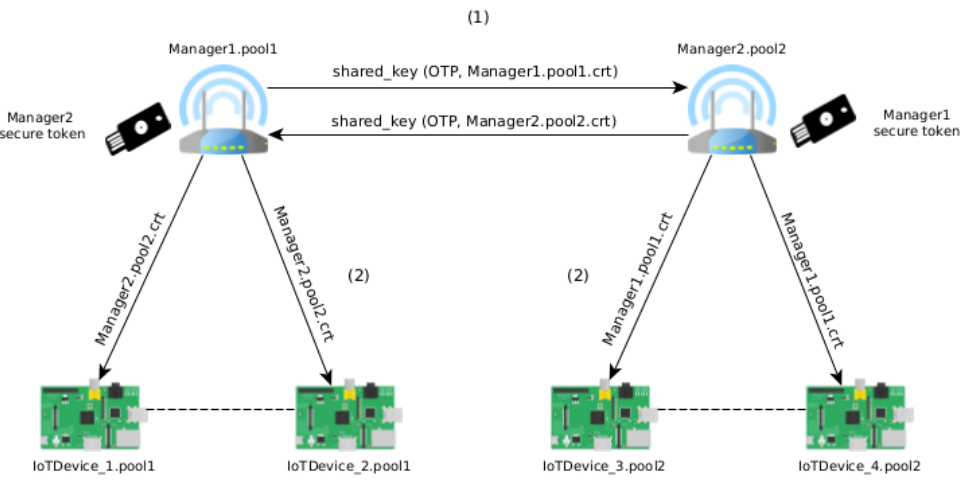
Figure 2. Merge two trusted